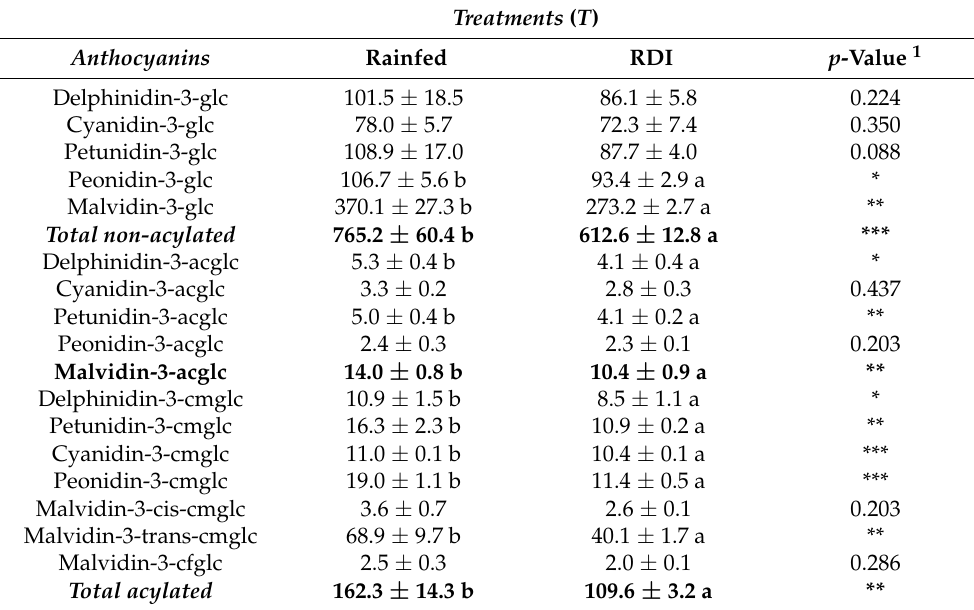
Table 1. Individual anthocyanin content (mg/kg) in Monastrell grapes from grapevines under non-irrigated (rainfed) and regulated deficit irrigation (RDI)